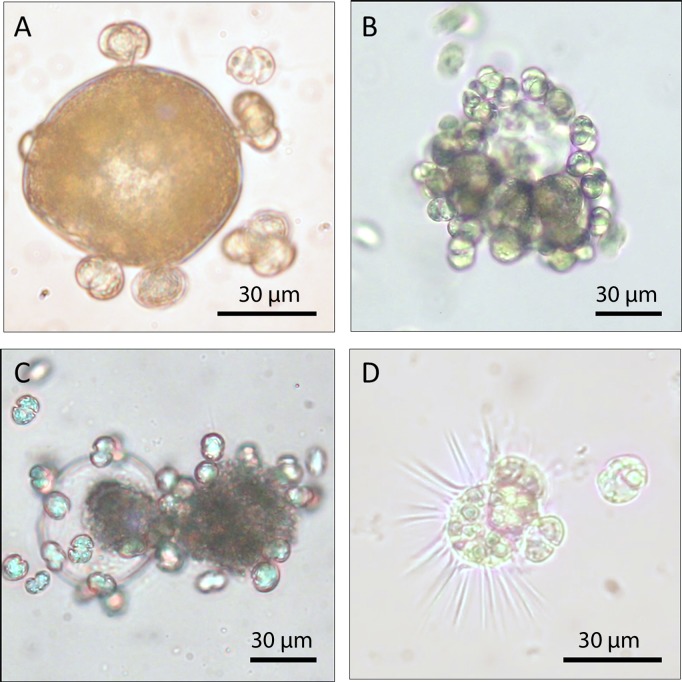
Karlodinium armiger tube feeding on Mytilus edulis embryos and trochophore larvae.Initial tube feeding by K. armiger on a mussel embryo (A). Karlodinium armiger cells attached to a mussel embryo causing the vitelline coat to disrupt and release of egg content (B). Karlodinium armiger attracted to egg content released from a disrupted embryos (C). Karlodinium armiger tube feeding on a mussel trochophore larva (D).